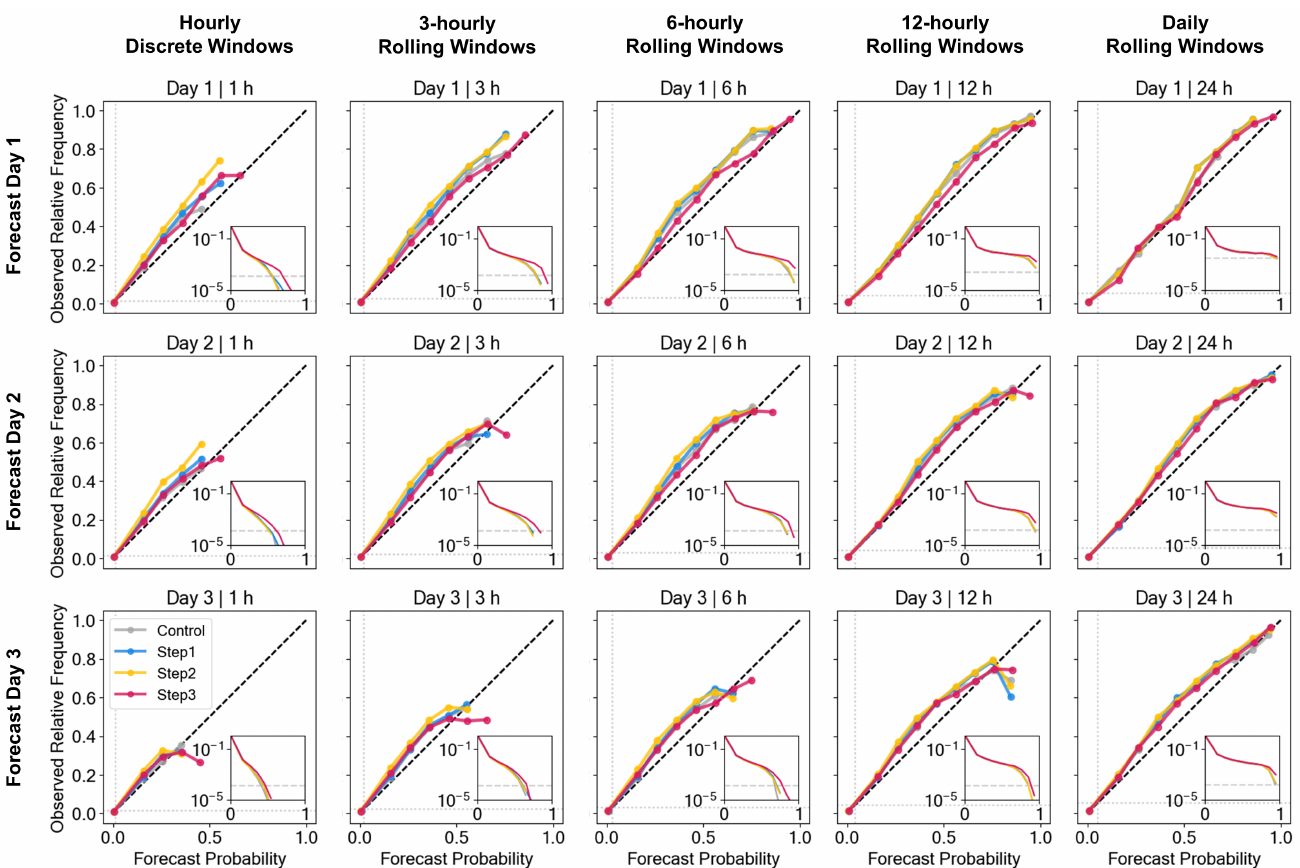
Figure 9. Station-aggregated 90p reliability diagrams on all forecast days for hourly discrete to daily rolling accumulation windows. The dashed black line is the reference for perfect reliability, the grey dotted lines show climatological probability. The inset in the lower right corner displays the corresponding sharpness diagram, which shows the relative frequency of forecasts that fall into each bin. Due to the skewed nature of precipitation distributions, the y-axis in the sharpness diagram is plotted on a logarithmic scale. The reliability diagram displays only bins that include at least 50 samples in total (i.e., only those points above the dashed grey line in the sharpness